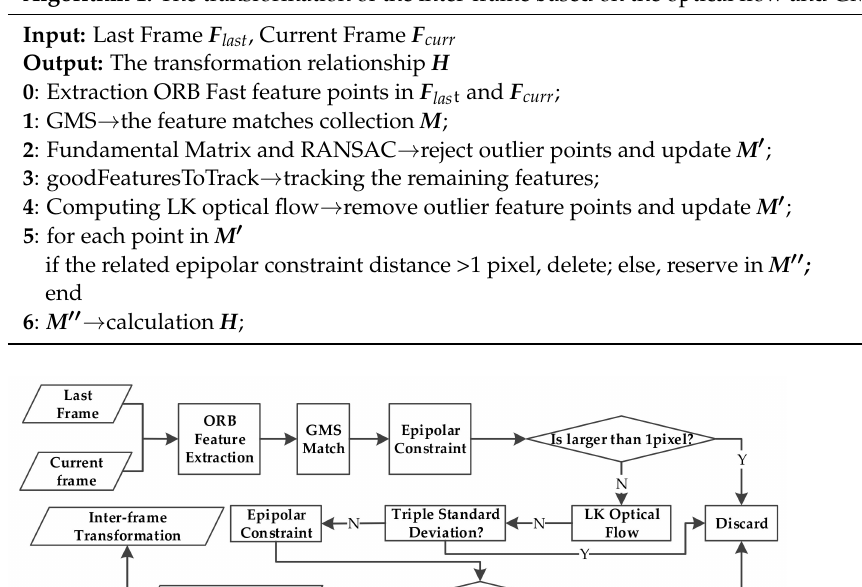
Algorithm 1: The transformation of the inter-frame based on the optical flow and GMS